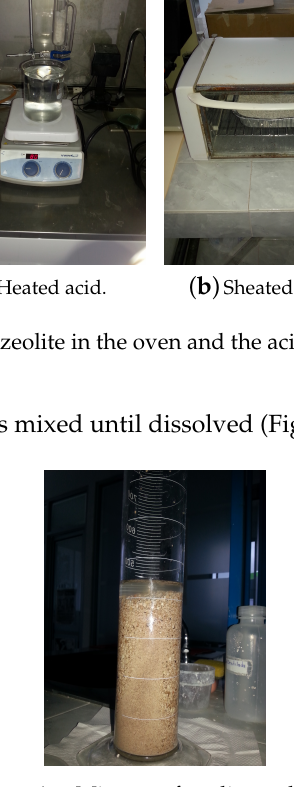
Figure A7. Mixture of zeolite and HCl.